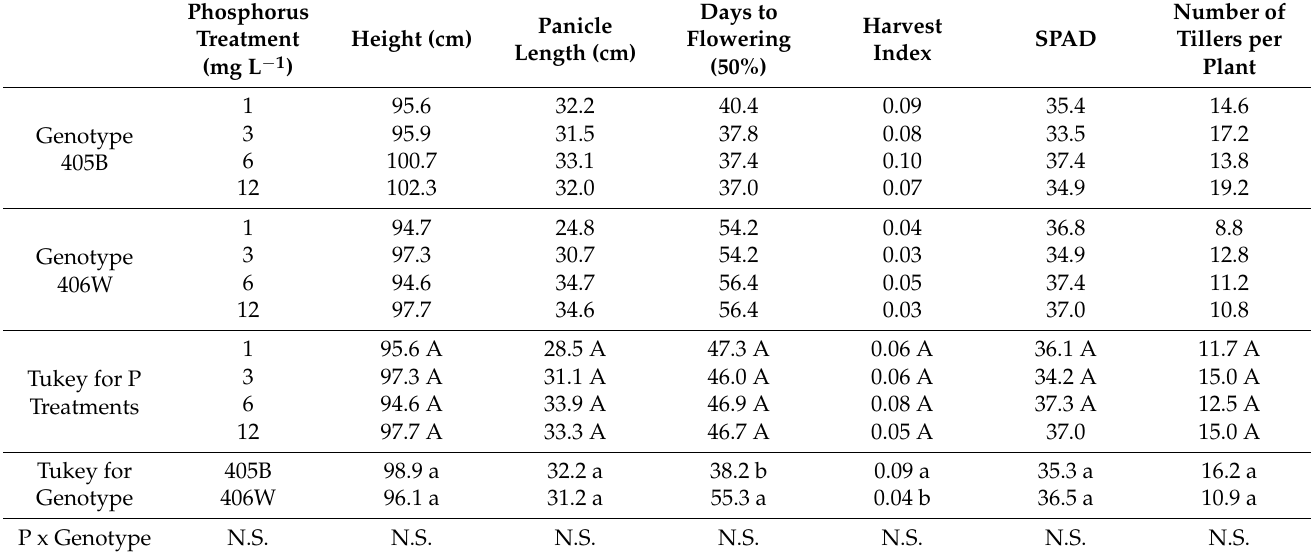
Table 3. Effect of P fertigation levels on growth parameters in the summer field experiment. Different letters represent significant (<0.05) differences for main effects. Upper case letters next to the values in the 3rd row represent the results of the Tukey test for nutrient concentration averaged across genotypes, and lower case letters next to the values in the 4th row represent the results of the Student- t test for the two different